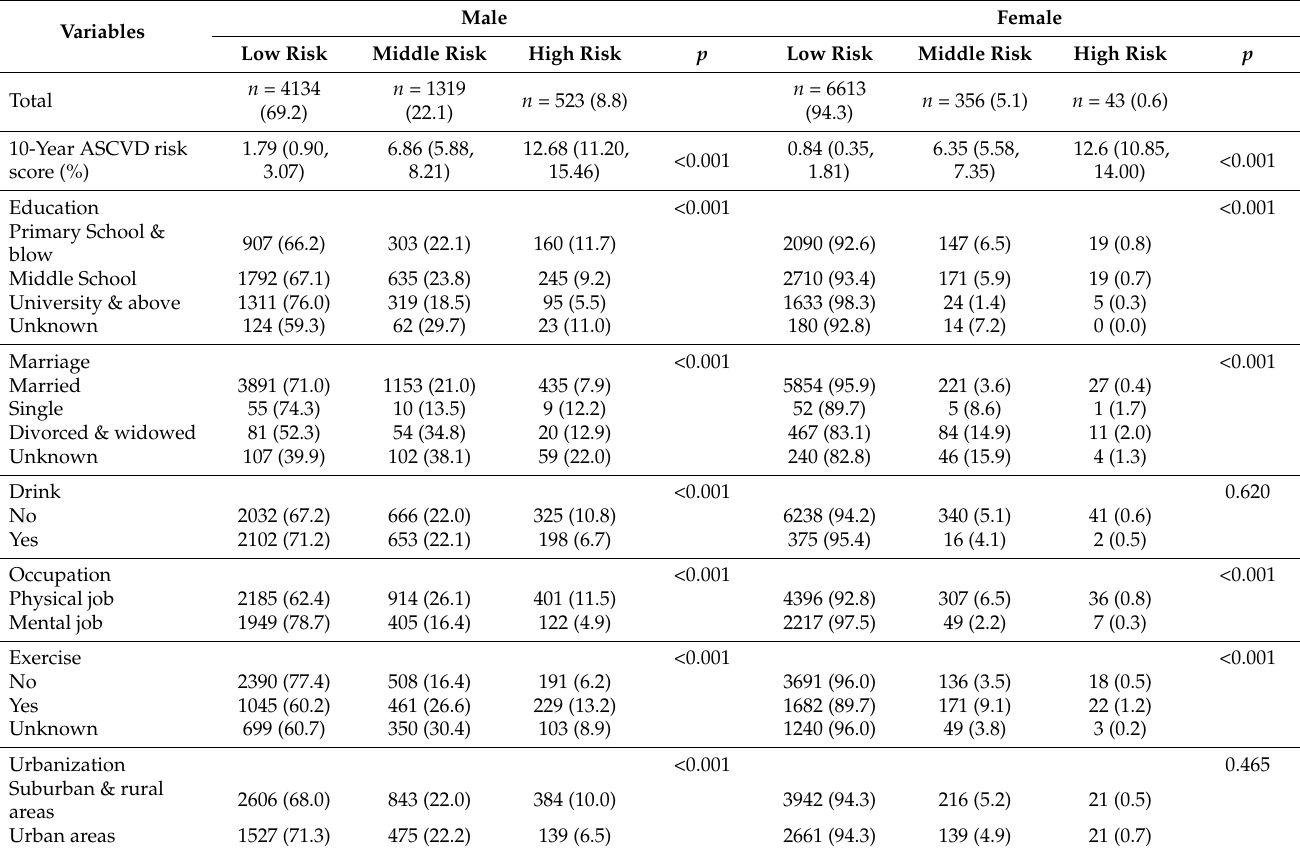
Table 2. Distribution of ASCVD risk levels among demographic characteristics by